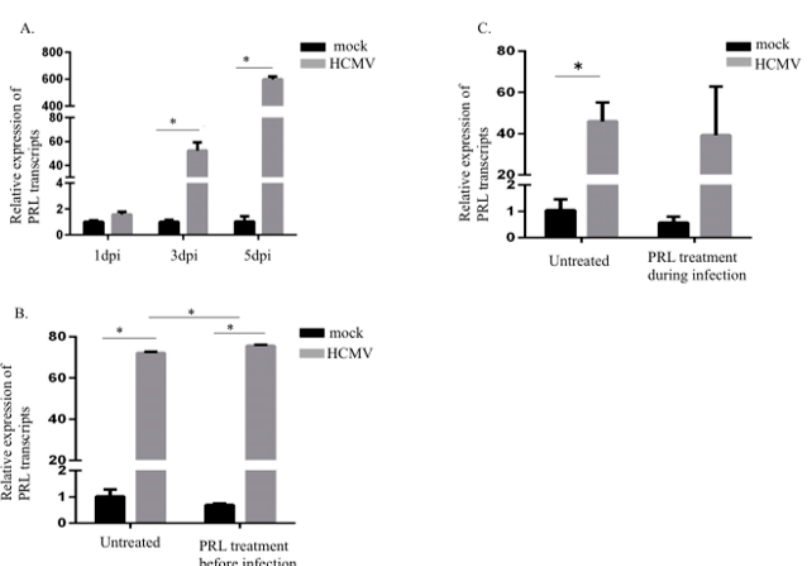
Figure 1. Prolactin (PRL) transcripts are increased in HCMV-infected SKOV3 cells. ( A ) Relative expression of PRL in SKOV3 cells infected with HCMV (MOI 5) compared to noninfected cells was determined by qPCR at 1, 3, and 5 dpi. ( B , C ) Relative expression of PRL in SKOV3 uninfected cells or infected with HCMV (MOI 5) after pretreatment or at the same time as treatment with PRL (200 ng / mL) was determined by qPCR at 3 dpi. Data is presented as mean ± SD ( n = 3). Statistical significance is indicated as * P < 0.05.